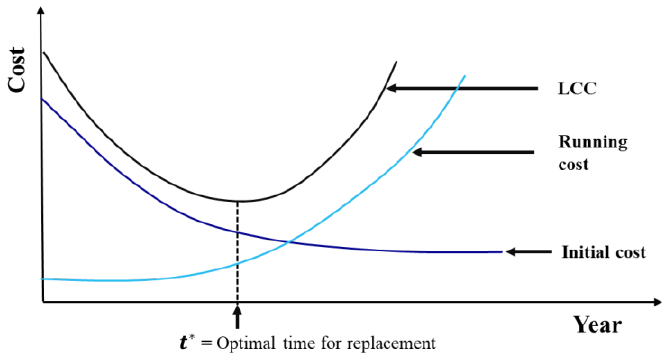
Figure 1. Example of life cycle cost (LCC) curve for obtaining the optimal pipe replacement age.